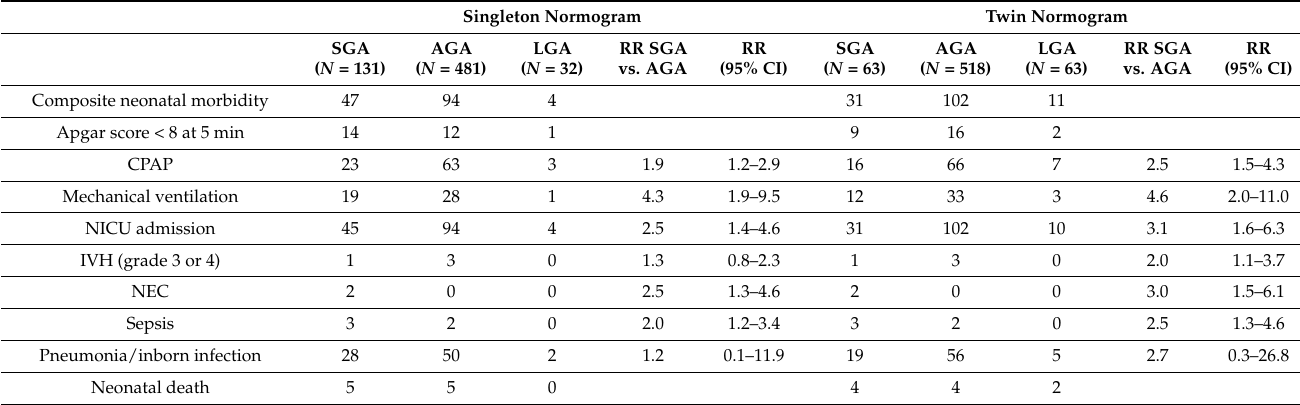
Table 2. Neonatal outcomes of the study group.